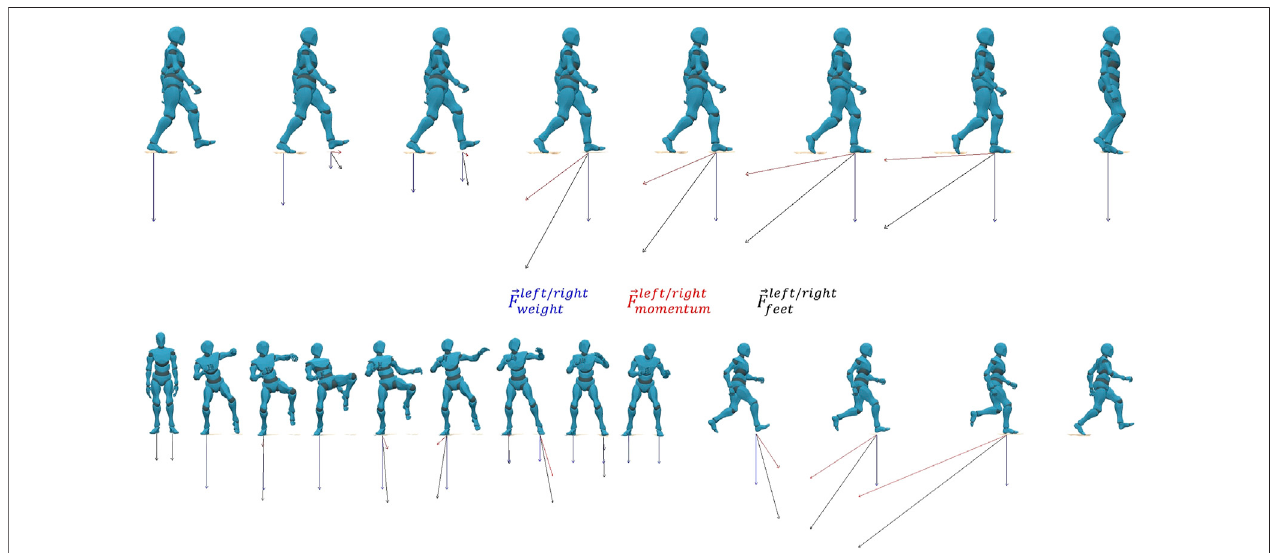
FIGURE5| Display ofthe force vectors (cid:2) F weight , (cid:2) F momentum , (cid:2) F foot foreach foot incontact withtheterrain. Thedistribution offorce automatically adapts totheleftand right foot depending on the posture of the character (top and bottom left). Higher velocity during a running motion increases the magnitude of the force (bottom right).